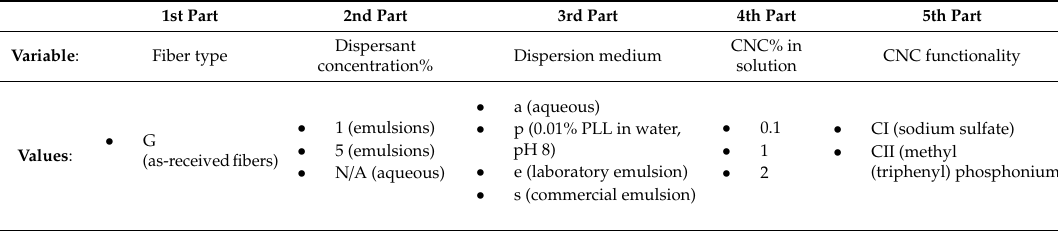
Table 1. Details of the naming scheme of the coating